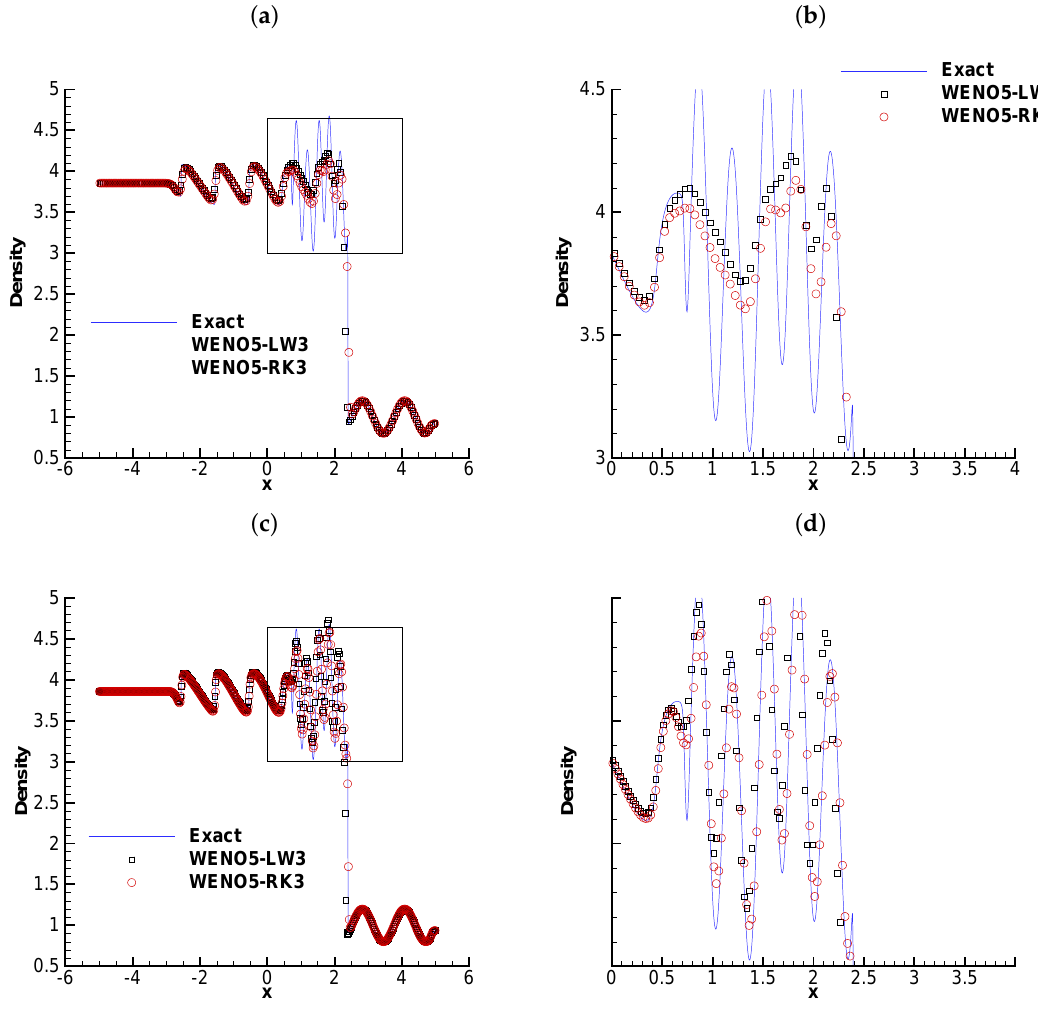
Figure 4. The shock density wave interaction problem at t = 1.8 by WENO5-LW3 and WENO5-RK3 with N = 200 and N = 400. ( a ) N = 200 for density; ( b ) N = 200 density zoomed in; ( c ) N = 400 for density; ( d ) N = 400 density zoomed